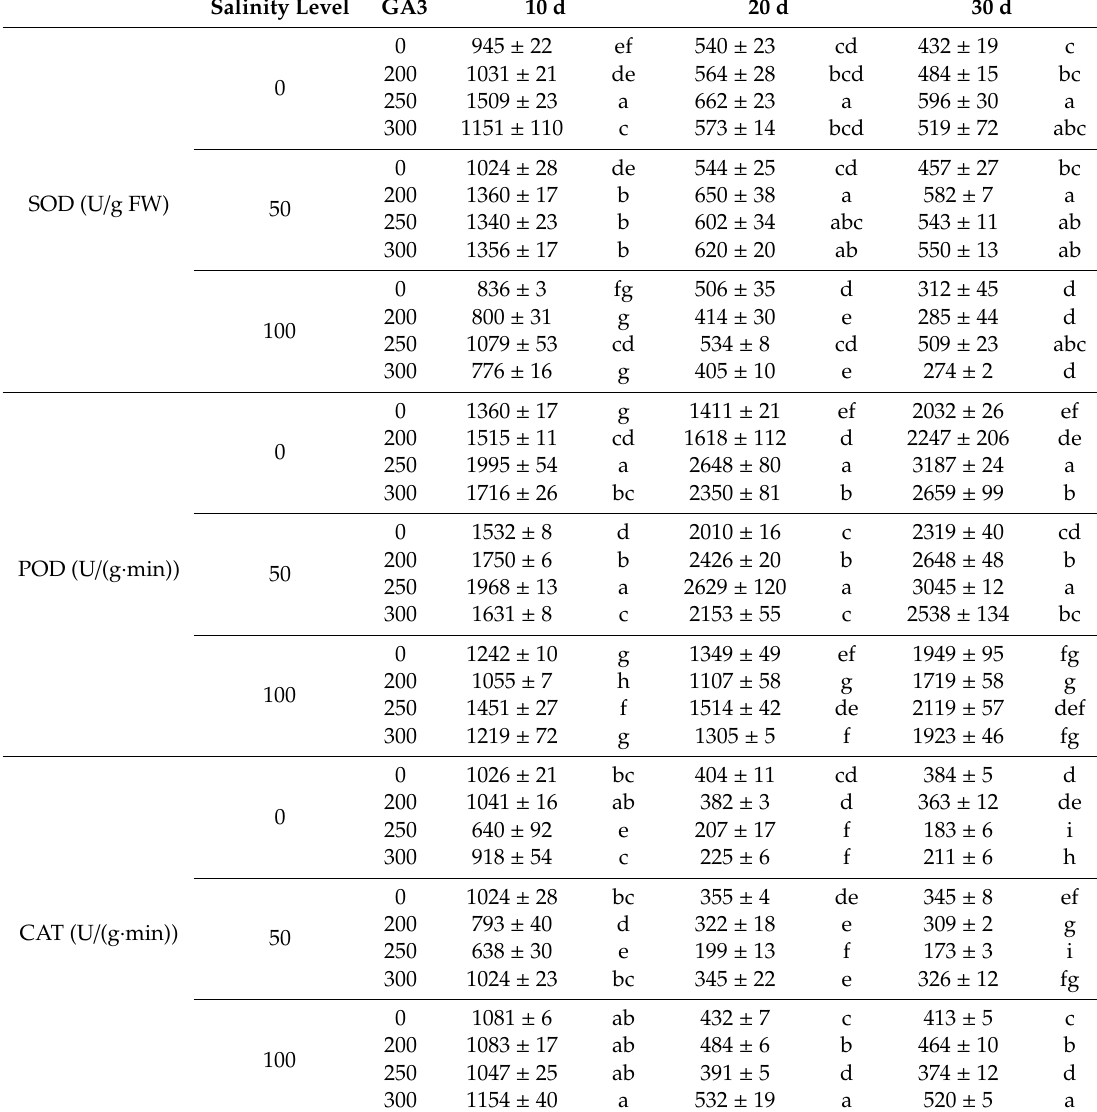
Table 4. E ff ects of di ff erent level of exogenous GA 3 on superoxide dismutase (SOD), peroxidase (POD), and catalase (CAT) of caster bean seedlings grown under three levels of NaCl treatment: 0 (control), 50, and 100